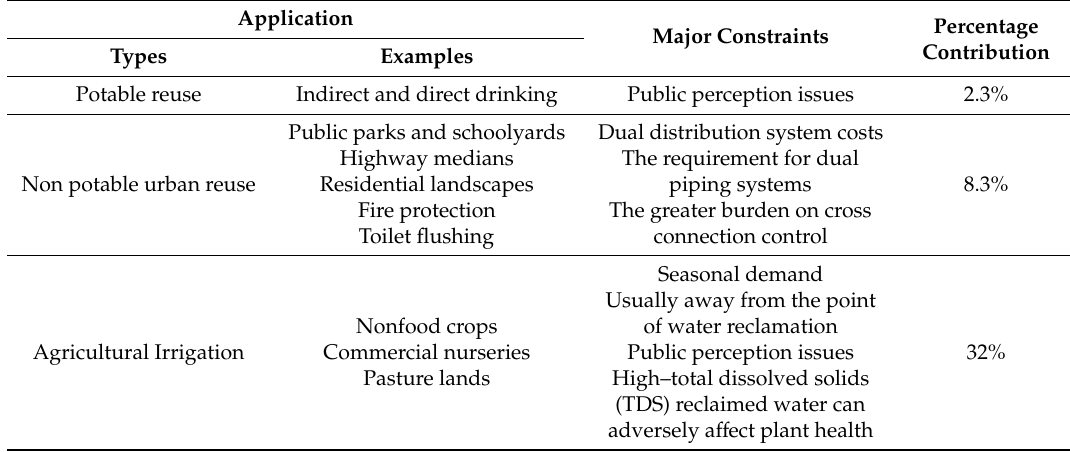
Table 1. Major water reuse applications and constraints worldwide